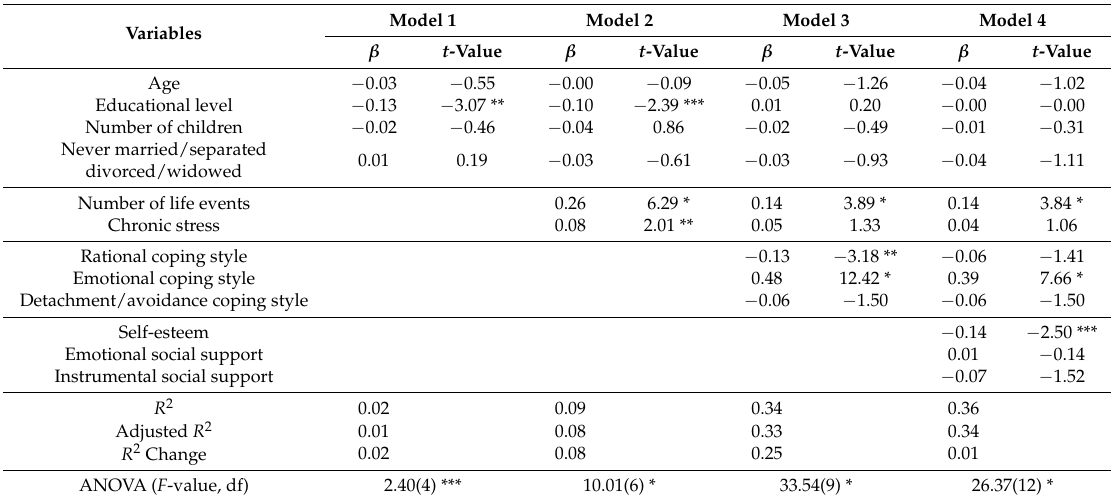
Table 3. Summary of the hierarchical regression with psychological distress as the dependent variable for the men group.